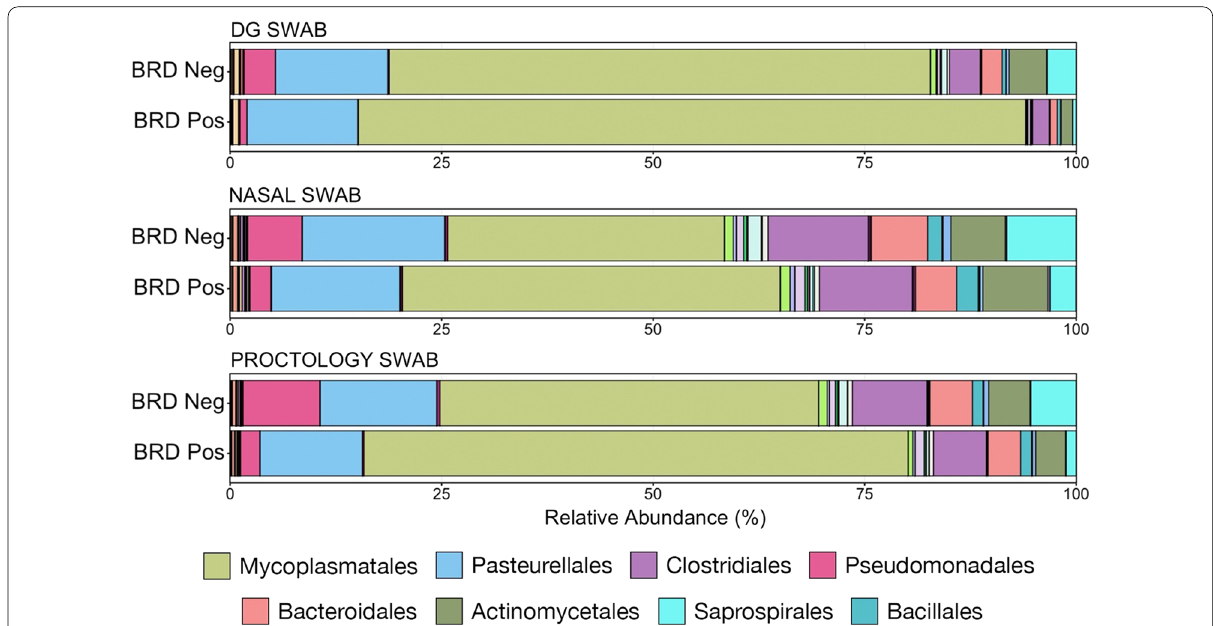
Fig. 7 Bar plot illustrating the mean relative abundance of microbial orders within BRD negative or positive animals as sampled with DG swab, NS, or PS. Abundances were normalized to the total number of CSS-normalized ASVs within each sample. The 8 most abundant orders are displayed in the